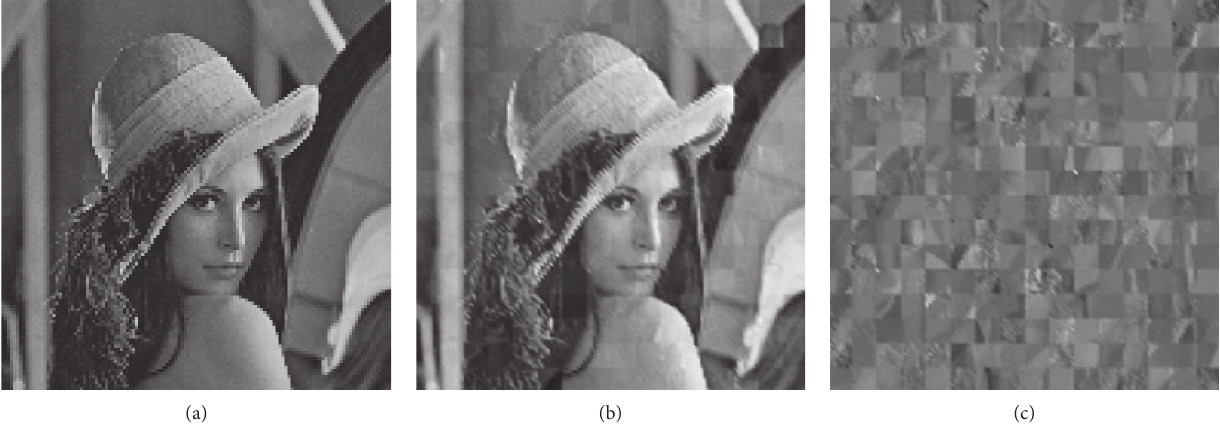
Figure 7: Reconstructed images for the sample object. (a) The original image. The reconstructed image with (b) the correct keys and (c) the incorrect